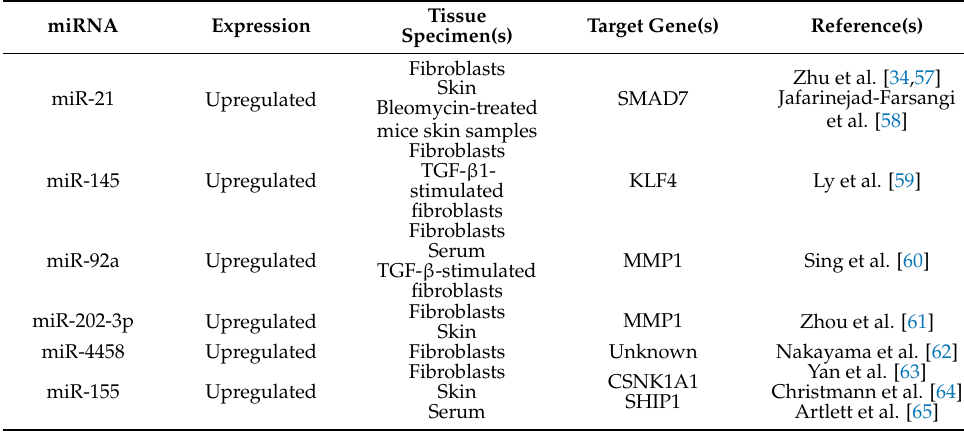
Table 1. Profibrotic miRNAs involved in SSc